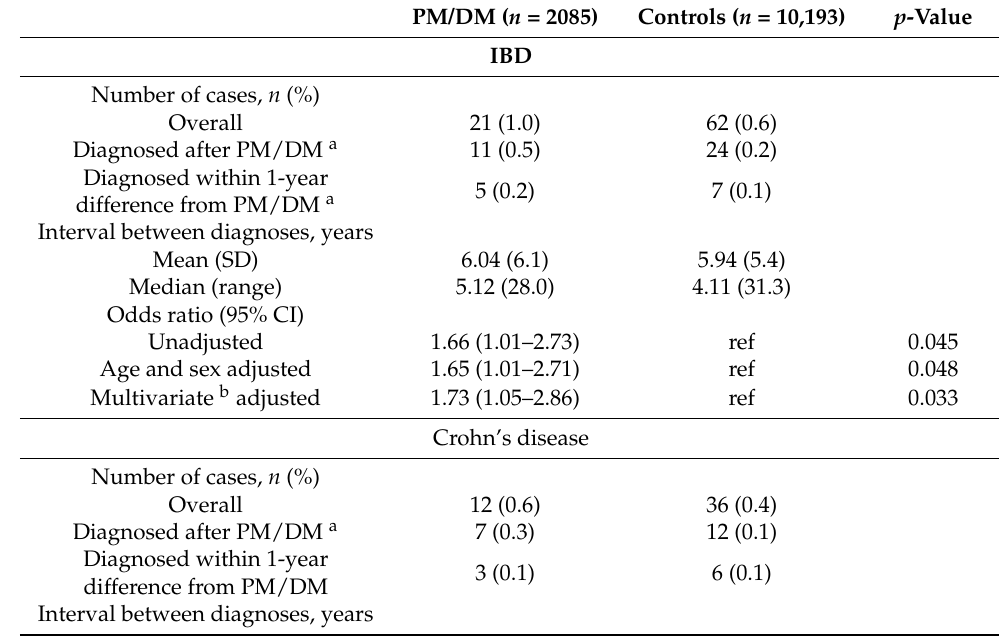
Table 2. Association of inflammatory myositis with IBD, logistic regression